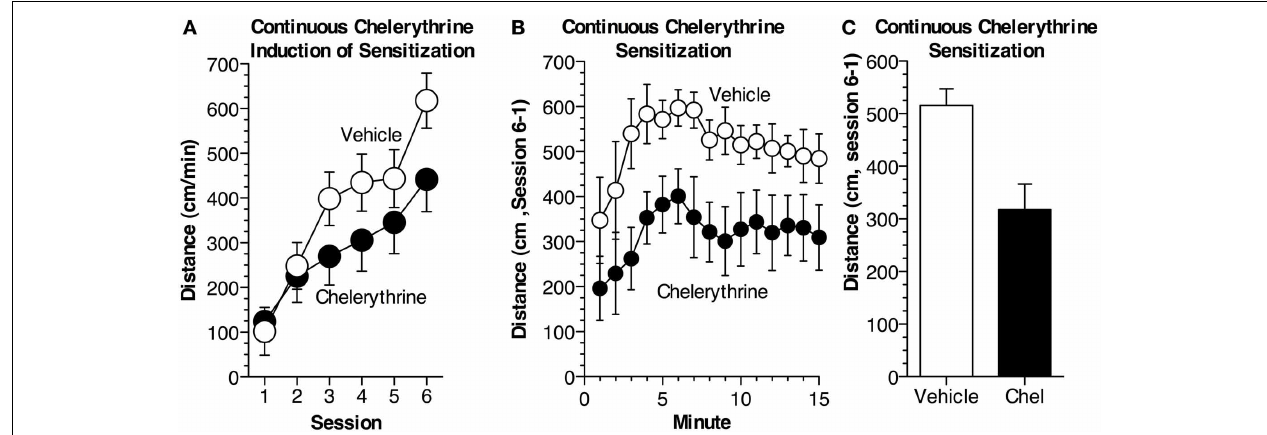
across the six sessions. (B) Sensitization, measured as the difference in distance traveled between the acute (session 1) and sensitized (session 6) response was significantly impaired in mice receiving chelerythrine across 15min [MANOVA, F ( 1 , 15 ) = 11 . 1, p < 0 . 01]. The difference in distance traveled ( ± s.e.m.) is shown for each minute. (C) Average sensitization ( ± s.e.m.) measured as the difference in distance traveled is shown for each